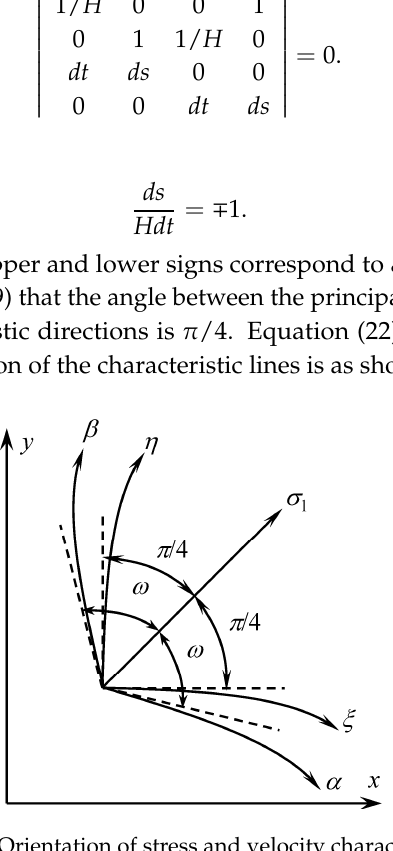
Figure 3. Orientation of stress and velocity characteristics.